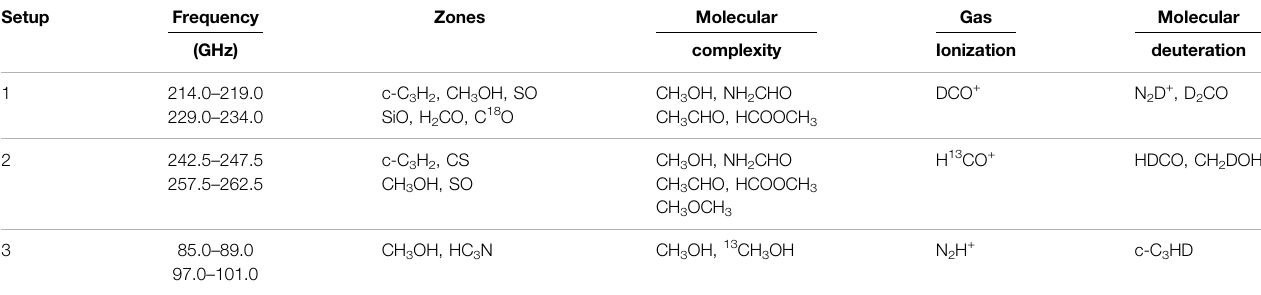
TABLE 1 | List of the frequency windows and of the species covered by the selected backends, divided in four groups (see Section 2.2 ).